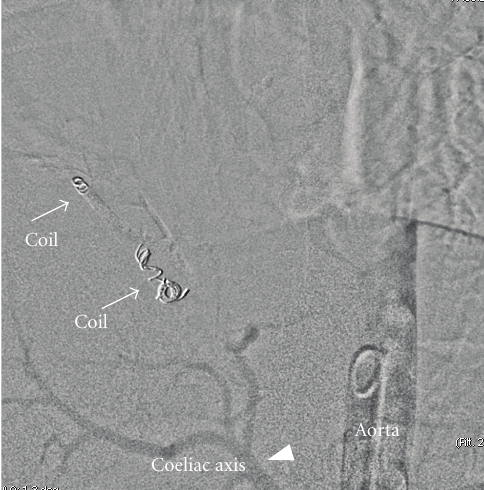
Figure 8: Intra-arterial digital subtraction angiogram following coil deployment depicts complete occlusion of anomalous arteries (arrows). Normal coeliac axis shown (arrow